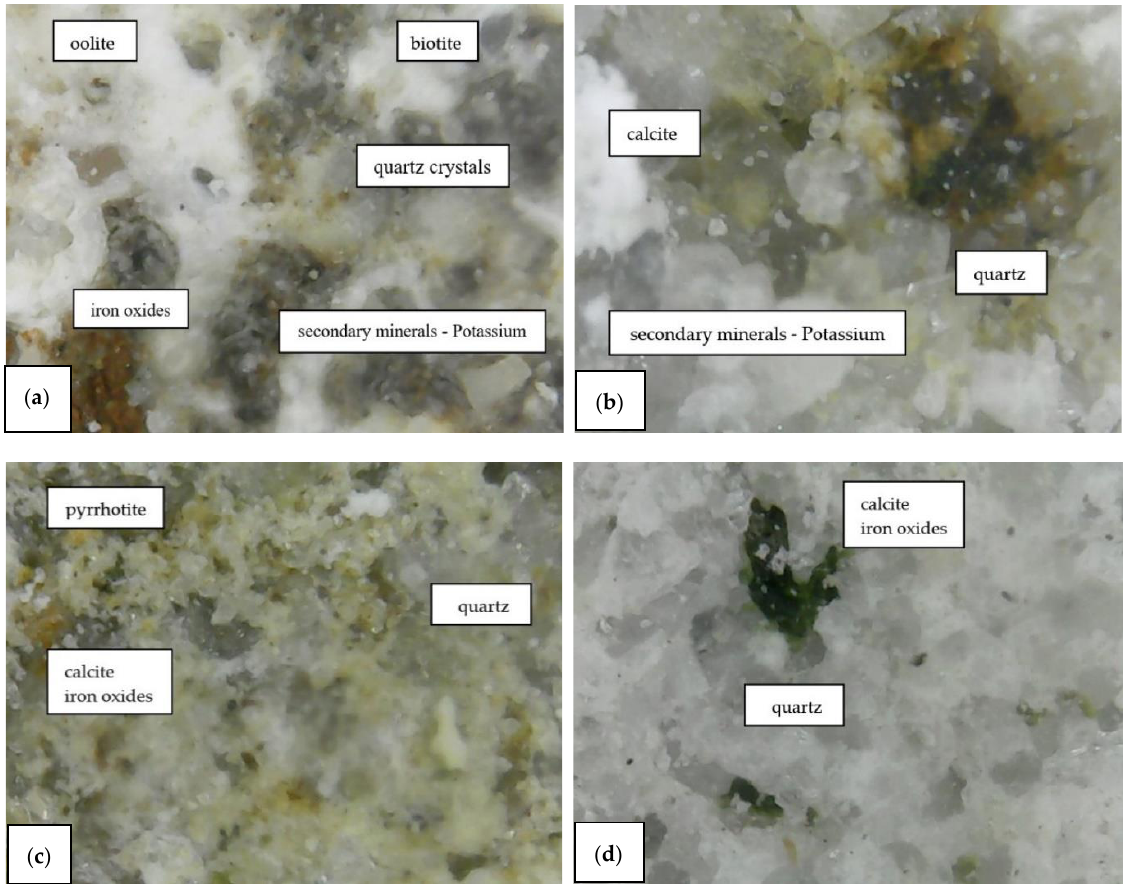
Figure 12. ( a ) S1 sample: magnification 500 X; ( b ) S2 sample: magnification 500 X; ( c ) S3 sample: magnification 500 X; ( d ) S4 sample: magnification 500 X. Table 3. The dimensions of the primary components of the S1 sample series.